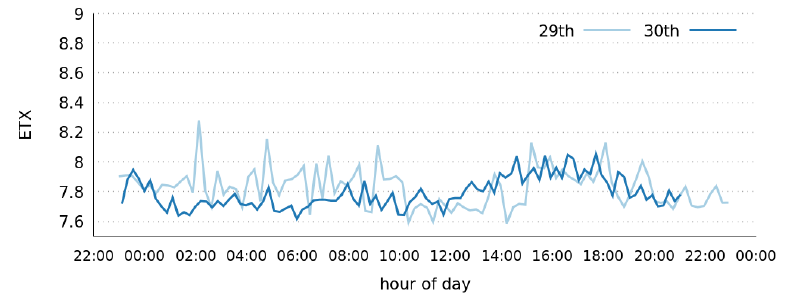
Figure 5. Temporal evolution of the average ETX of paths (non-working days).